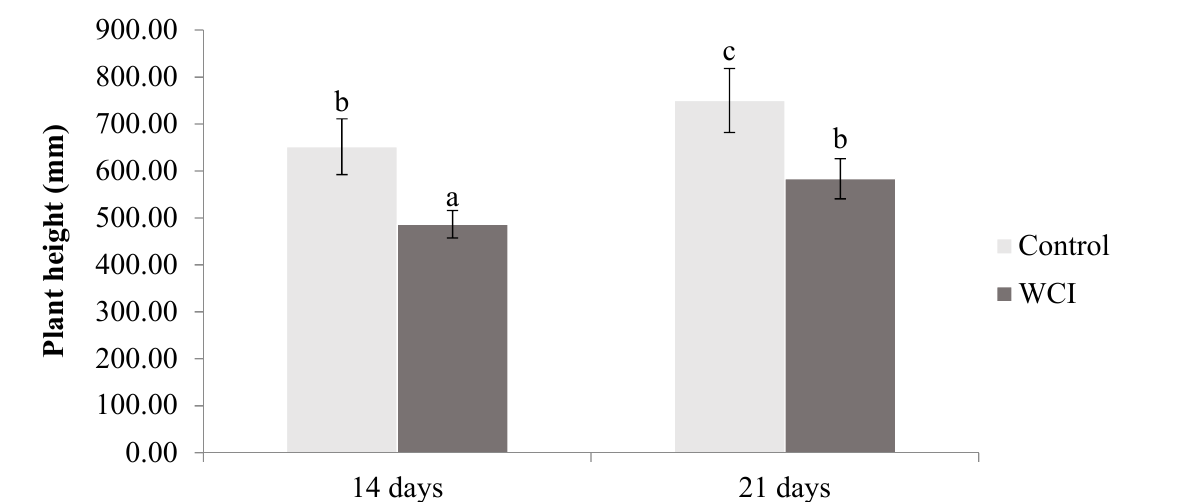
Figure 3. The effect of woolly cupgrass infestation (WCI) on the maize plant height (14 and 21 d.a.s.) (values represent means ± SD, n = 10). Small letters (a, b, c) show significant differences between treatments based on independent t -test ( p < 0.05).